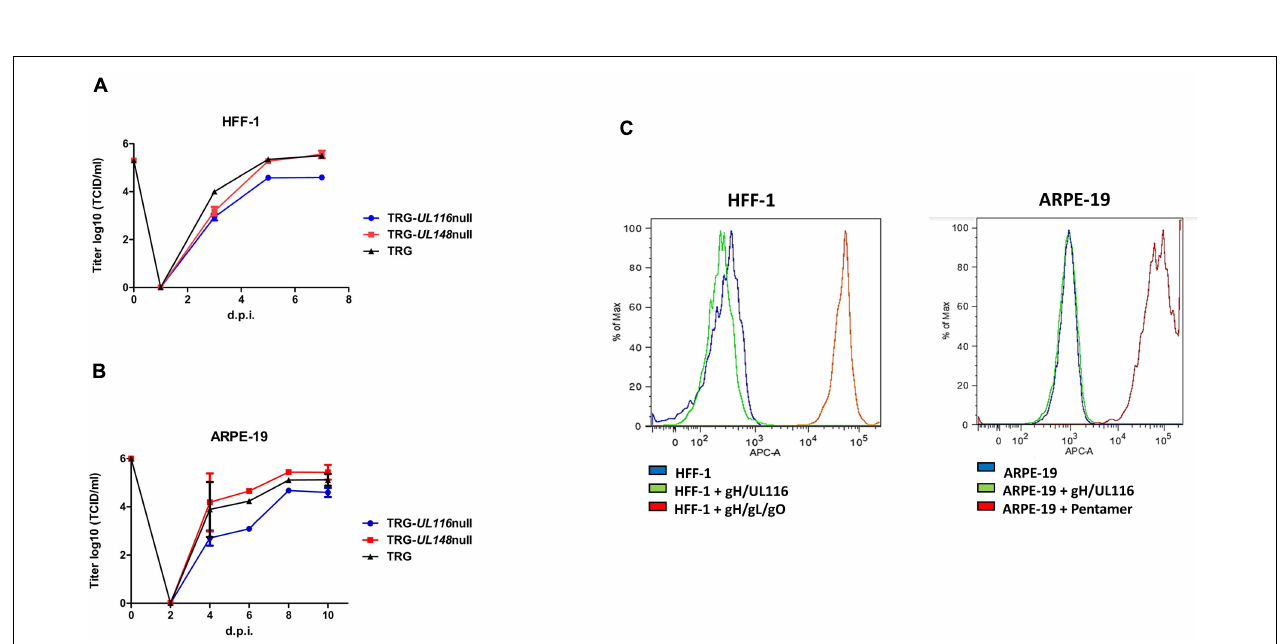
FIGURE 2 | Growth curve of TRG, TRG-UL 116 null, and TRG-UL 148 null and binding of recombinant gH/UL116 to HFF-1 and ARPE-19. (A) HFF-1 cells were infected at MOI 1 and cultured for 7 days. At the indicated times, an aliquot of medium were withdrawn and viral titer assessed on fibroblasts. (B) ARPE-19 cells were infected at MOI 5 and cultured for 10 days. At the indicated times, an aliquotof the medium were withdrawn and viral titer assessed on fibroblasts. (C) 200 µ g/ml of recombinant gH/UL116, Trimer and Pentamer were incubated for 1 h with 10 5 cells in blocking buffer (PBS with 1% BSA). His tag was present on recombinant gH. His-Tag Monoclonal Antibody [HIS.H8] and then Alexa Fluor 647-conjugated anti-mouse secondary antibody were used to reveal complexes bound to cells. A total of 10 5 cells were analyzed for each histogram using FACS BD Canto II (Becton Dickinson, Heidelberg,